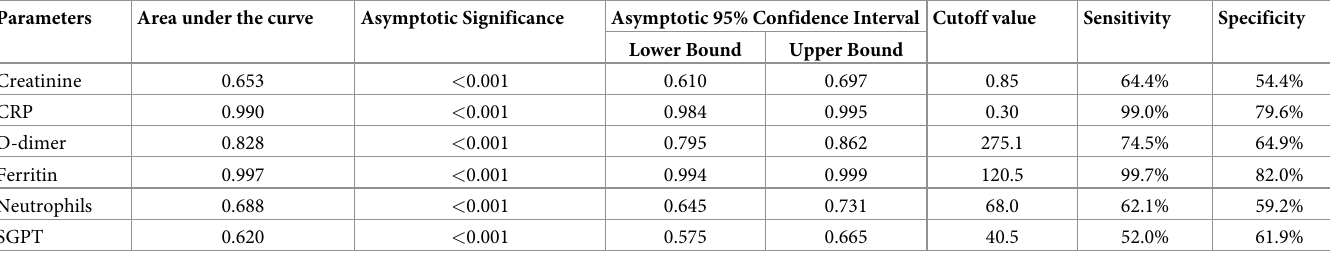
Table 5. Receiver operating characteristic analysis of promising markers for severity of COVID-19.